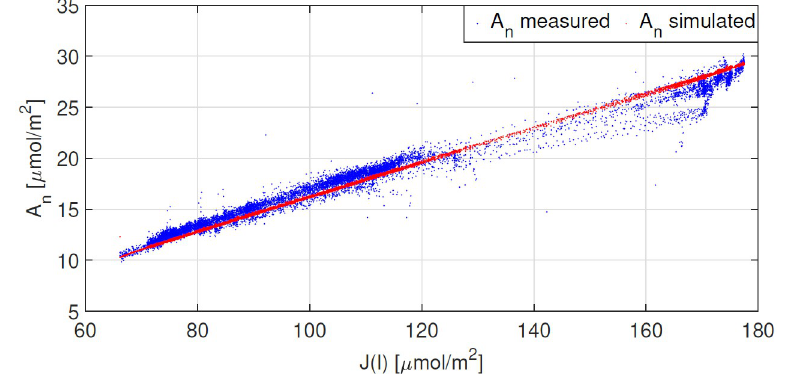
Fig 9. Results obtained for the validation data set measured on 7 Sept 2021 under elevated c a = 800ppm. The correlation between A n and the electron transport rate (J(I(t)) is shown for both measured and simulated data sets.